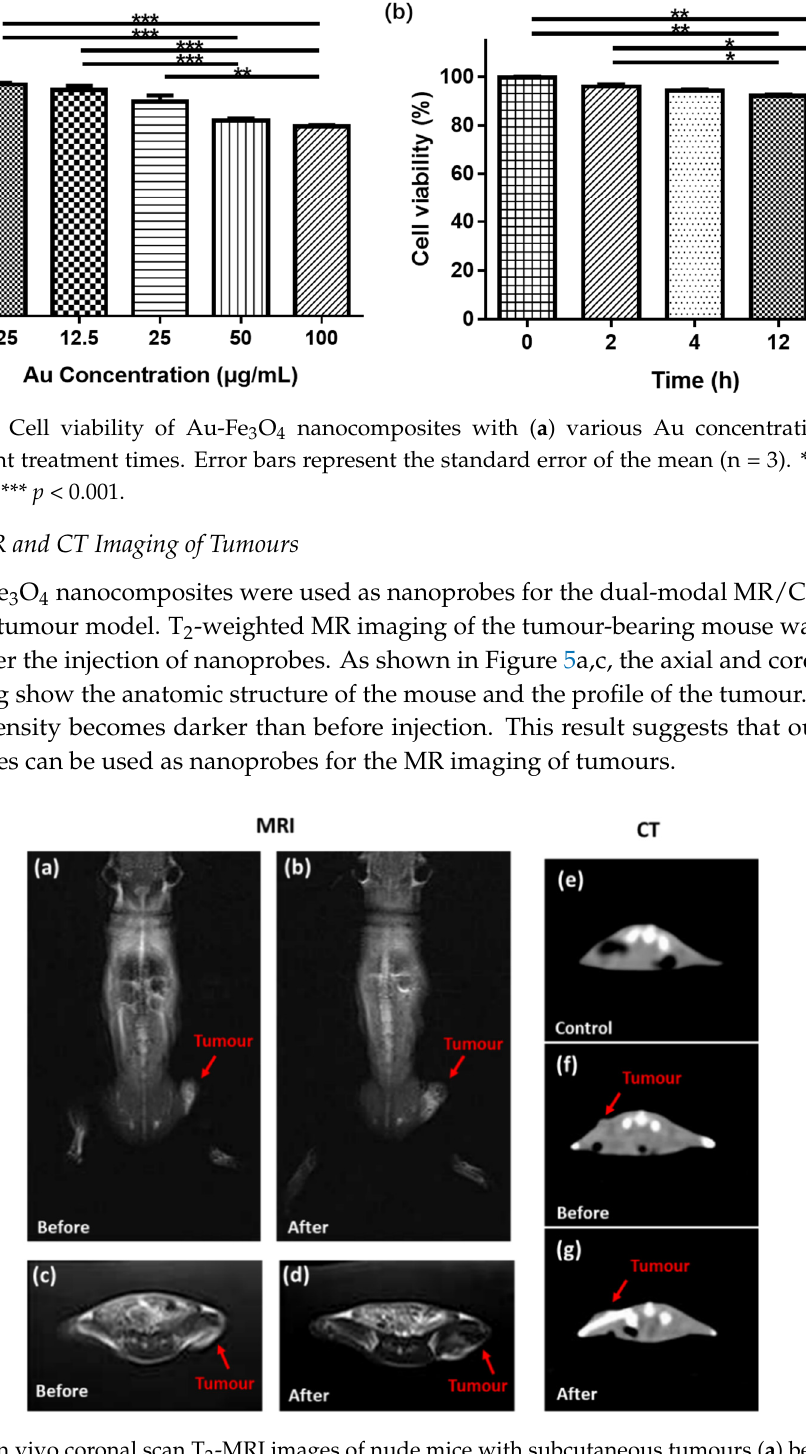
Figure 4. Cell viability of Au-Fe 3 O 4 nanocomposites with ( a ) various A u concentrations and ( b ) different treatment times. Error bars represent the standard error of the mean (n = 3). * p < 0.05; ** p < 0.01; *** p < 0.001.